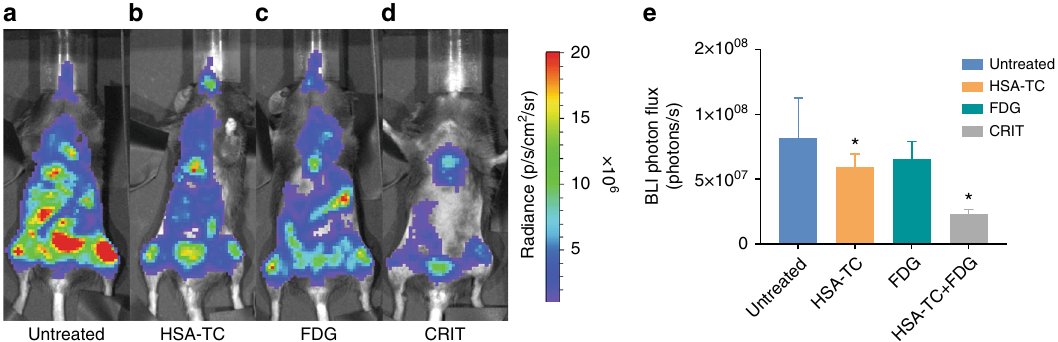
Fig. 6 Representative BLI of PyMT-BO1 GFP/Luc metastatic breast cancer cells in C57B6. a Untreated C57B6 mouse bearing highly metastatic PyMT-BO1 cancer. Accumulation in the lower limbs were predominant. b Mouse treated with 30 mg kg − 1 of HSA-TC nanoparticles. c Mouse treated with 800 µ Ci of 18 FDG. d Mouse treated with a combination of HSA-TC and 800 µ Ci 18 FDG. e Quanti fi cation of whole-body luminescence in CRIT-treated mice compared to untreated, HSA-TC treated or 18 FDG-treated controls (* P values are 0.038, 0.23 and 0.017 for CRIT, HSA-TC alone and 18 FDG alone, respectively). BLI and data analysis were performed on day 9 after initiation of PyMT-BO1 metastasis in mice. Studies were performed with n = 5 mice per each group